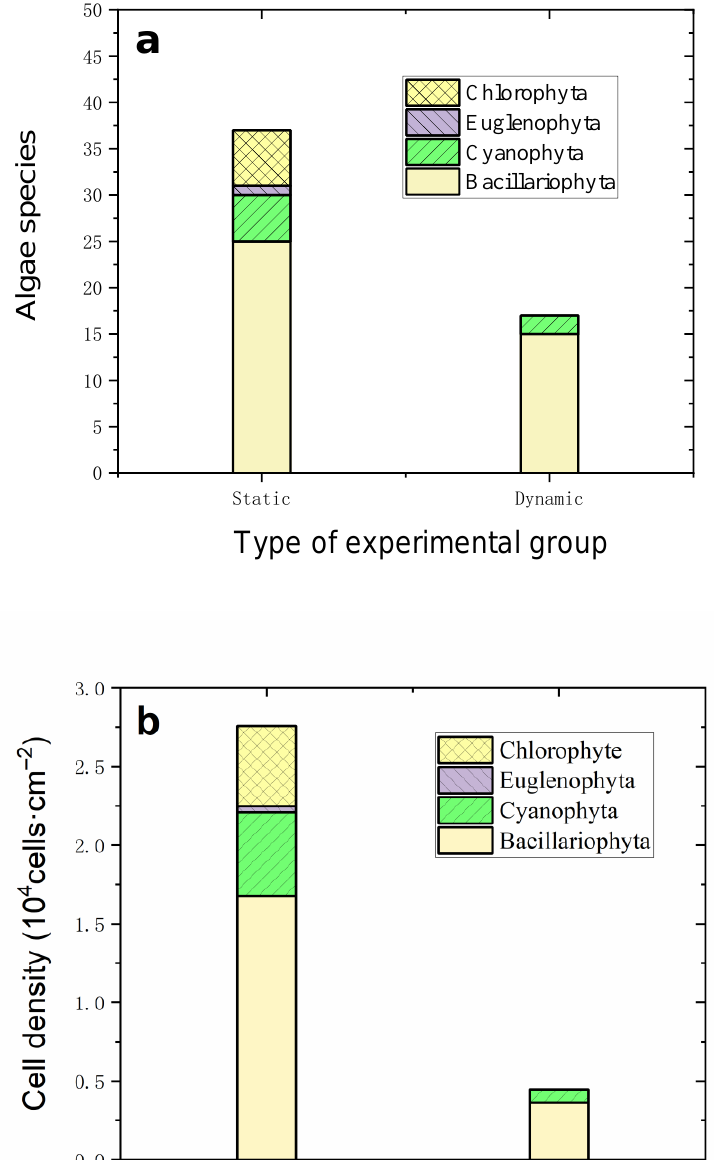
Table 1. Effects of water flow on the dominant genus, species and dominant index on the epiphytic biofilm of V. natans.